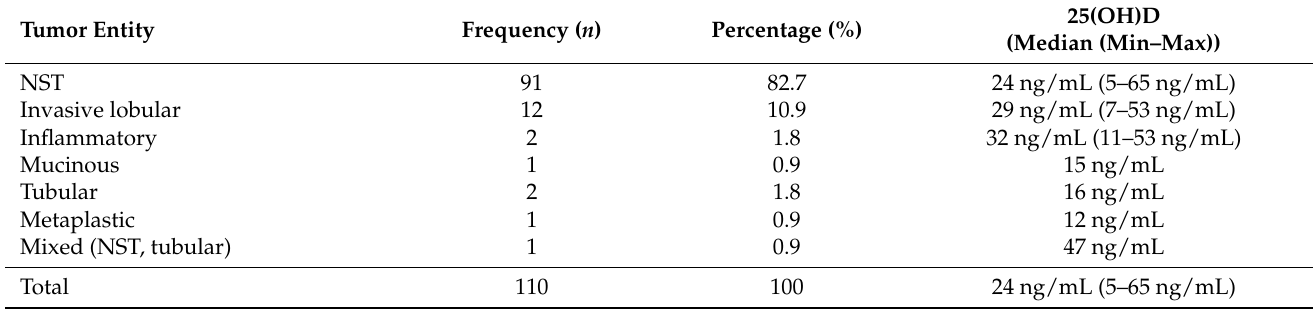
Table 2. Tumor entity and serum 25-hydroxyvitamin D (25(OH)D) levels. “NST” = No special